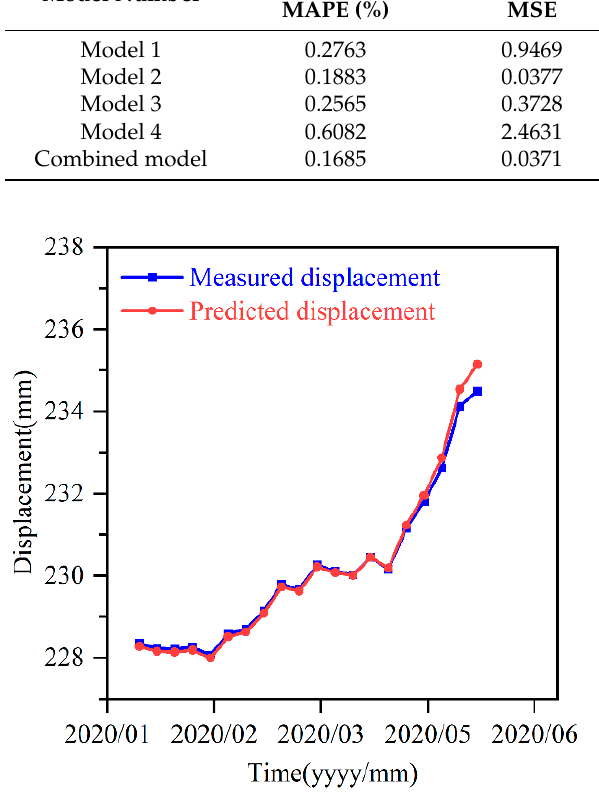
Figure 12. Cumulative displacement prediction results of the combined model.